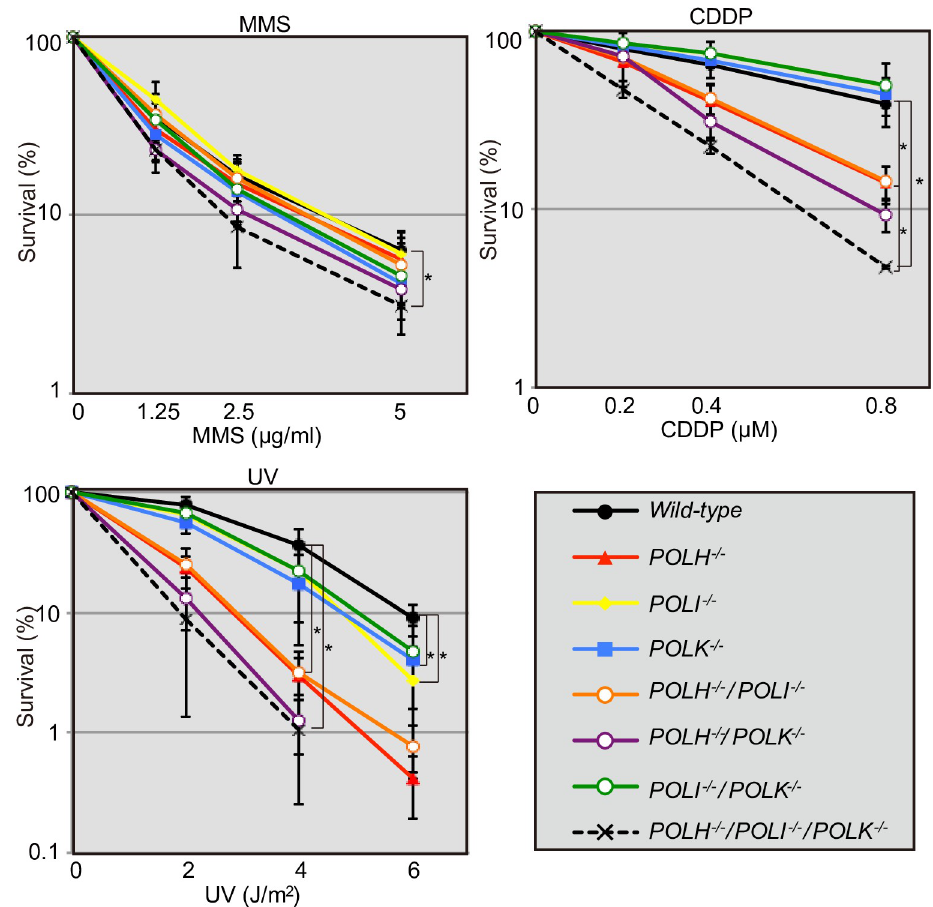
Fig 2. The relationship between Pol η , Pol ι , and Pol κ in cellular tolerance to MMS, CDDP, and UV. (A-C) Indicated TK6 cells were assessed for sensitivity to MMS (A), CDDP (B), and UV (C) as in Fig 1. Data for the CDDP sensitivity for POLI −/− were completely overlayed by the data for POLI −/− / POLK −/− . The dose of DNA-damaging agents is displayed on the x-axis on a linear scale, while the percentage of cell survival is displayed on the y-axis on a logarithmic scale. Error bars represent the standard deviation from three independent experiments. The p -value was calculated by Student’s t -test ( � p < 0.05).